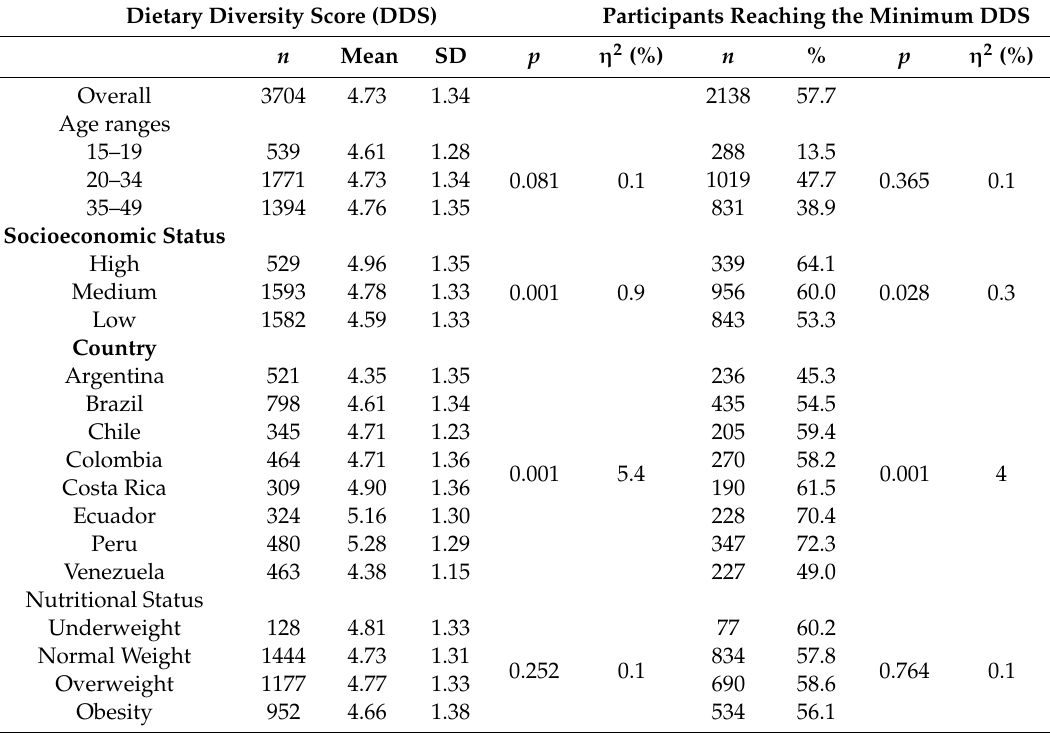
Table 2. Sample characteristics, Diet Diversity Score (DDS) and proportion of participants reaching the minimal DDS (consumption of at least five out of 10 Food Groups) in ELANS. Dietary Diversity Score